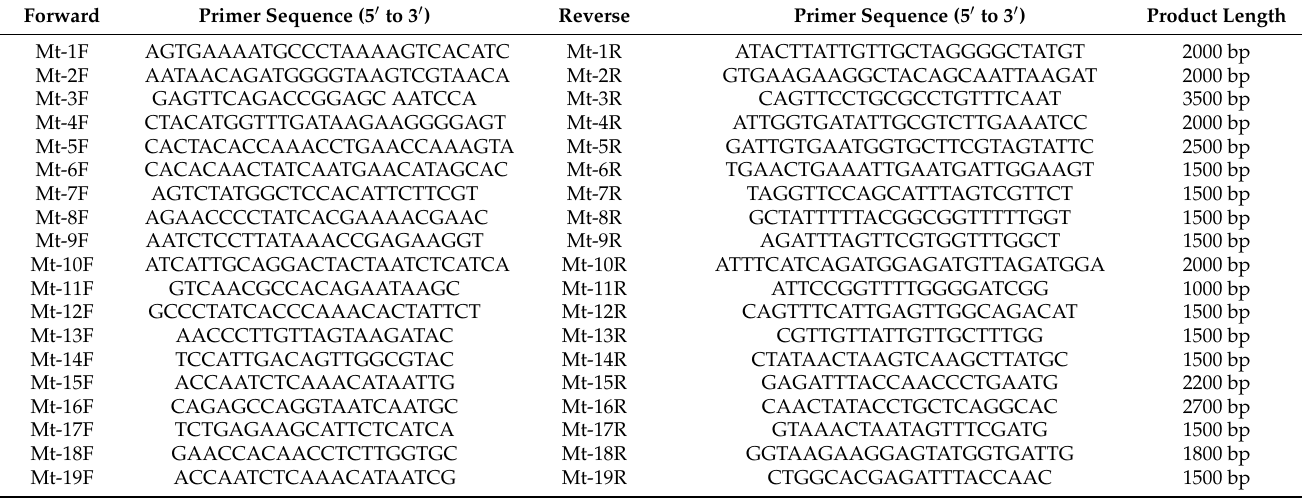
Table 1. Primers used for amplification of mitochondrial